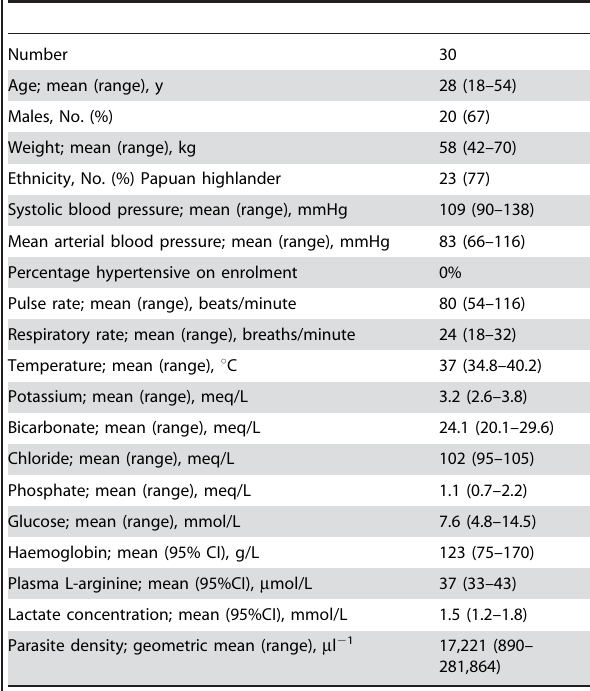
Table 1. Baseline characteristics of patients who received L- arginine